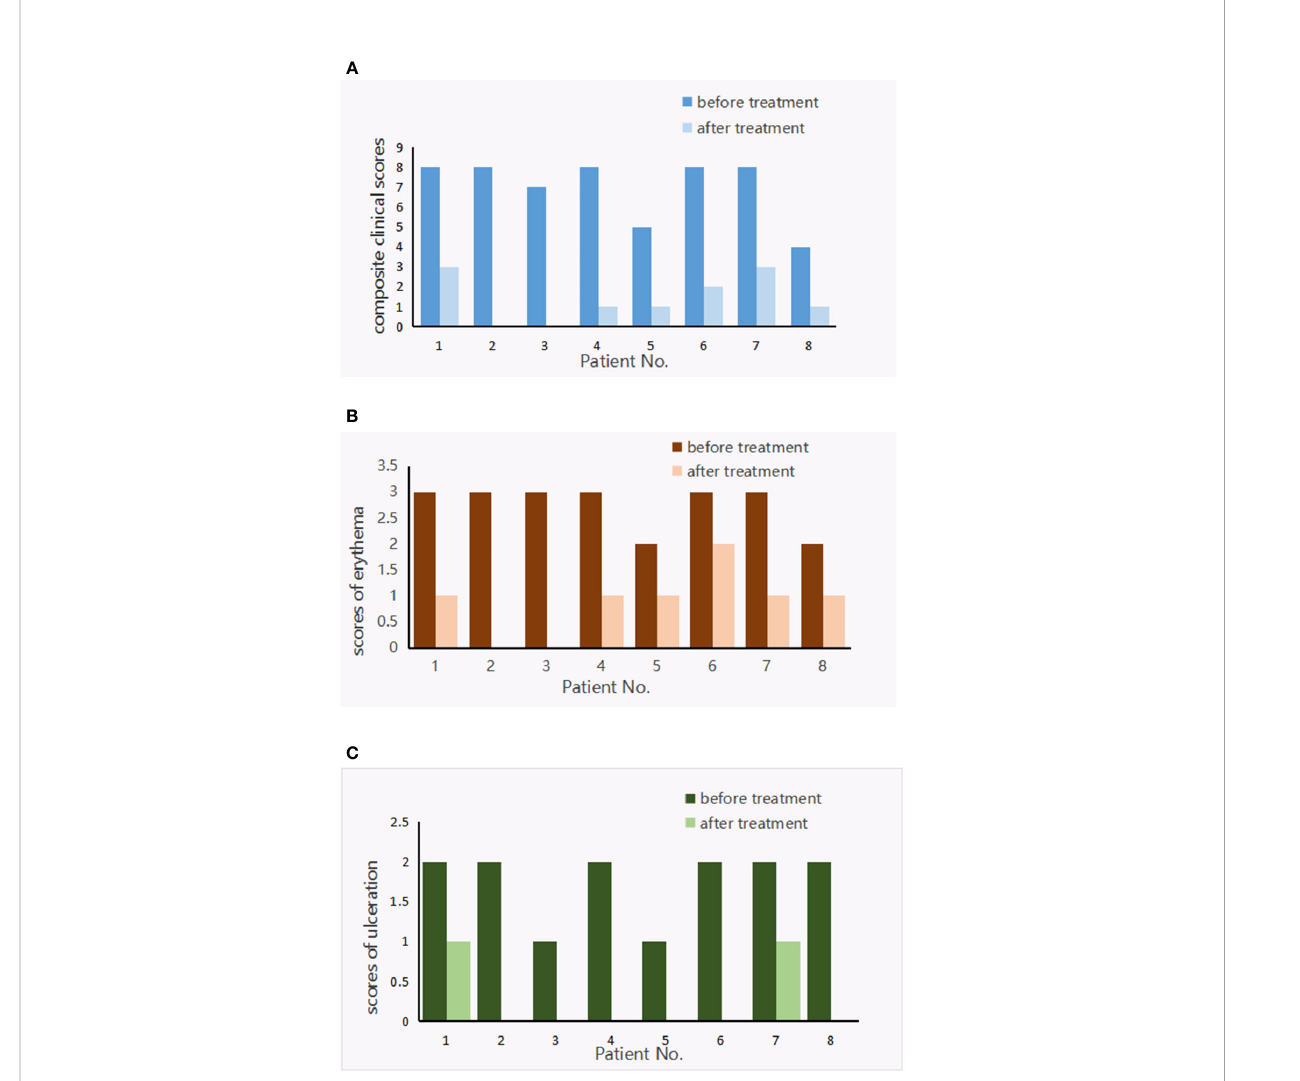
FIGURE 1 Livedoid vasculopathy composite clinical scores (A) , scores of erythema (B) and ulceration (C) before and after treatment with